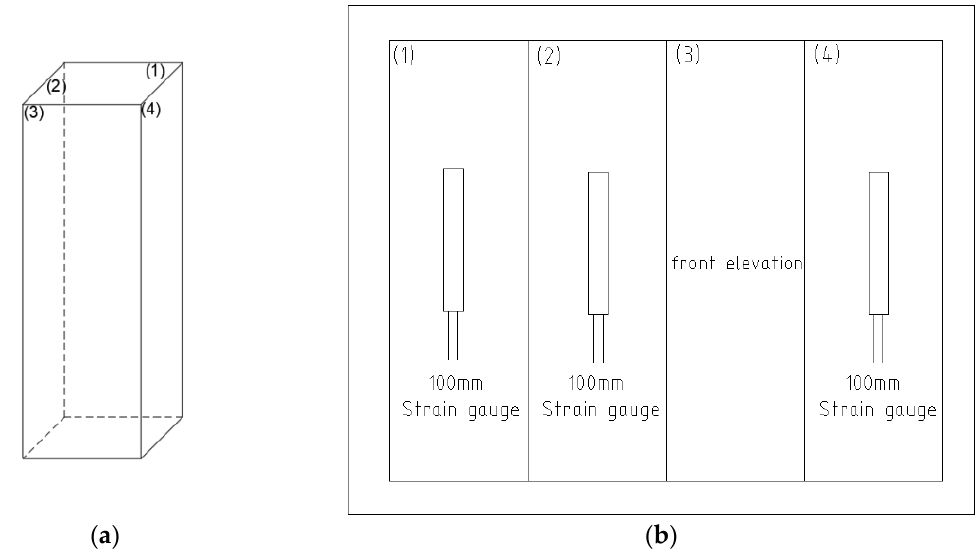
Figure 8. Strain gauge arrangement of BFRC specimen. ( a ) Concrete prisms. ( b ) Prismatic full-sided expansion.